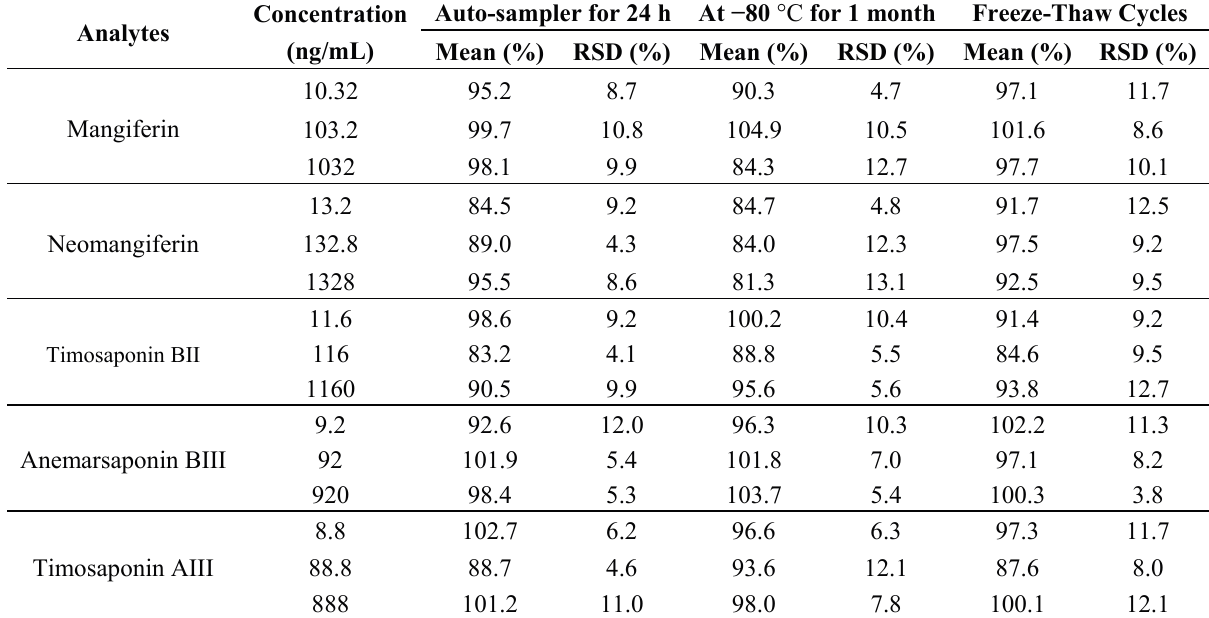
Table 3. Stability for five analytes in rat plasma (n = 5).